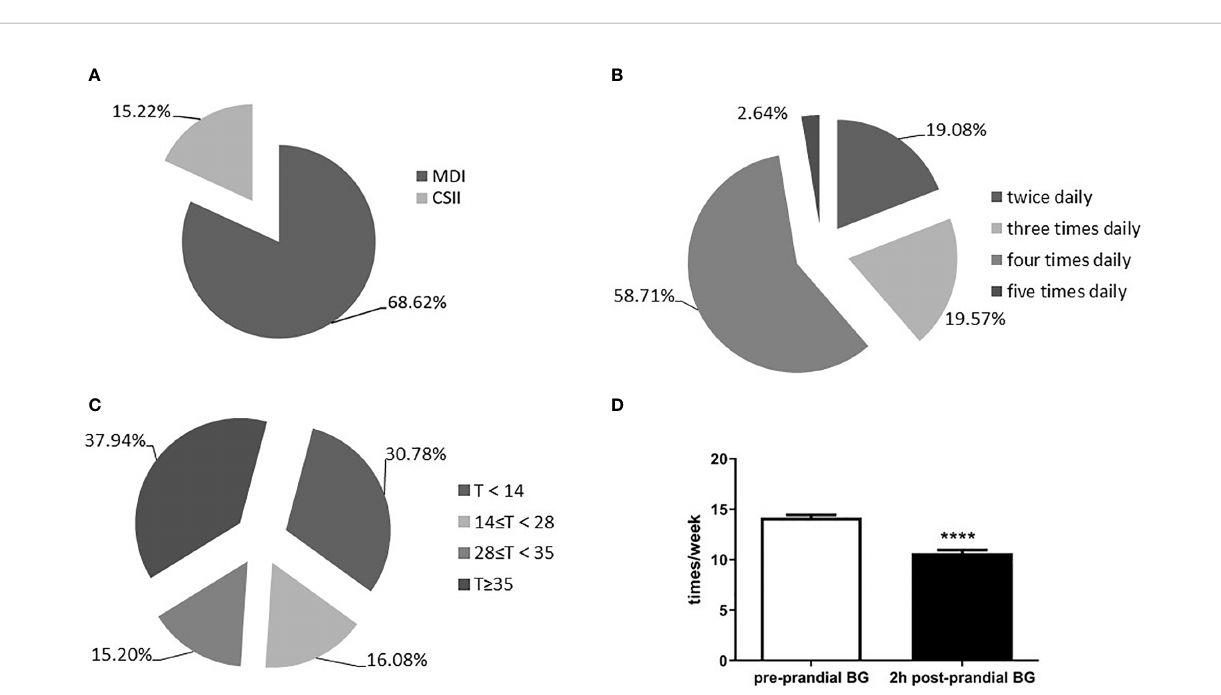
FIGURE 1 | The diagram of predicators in T1DM children at presentation. (A) Average onset age between DKA and non-DKA groups; (B) Proportion of female between DKA and non-DKA groups; (C) HbA1c level between DKA and non-DKA groups; (D) Frequency of DKA between patients under 5 years old and over 5 years old; (E) DKA frequency of different age groups; (F) HbA1c level of different age groups *p < 0.05, **p < 0.01,****p < 0.0001. ns p > 0.05.